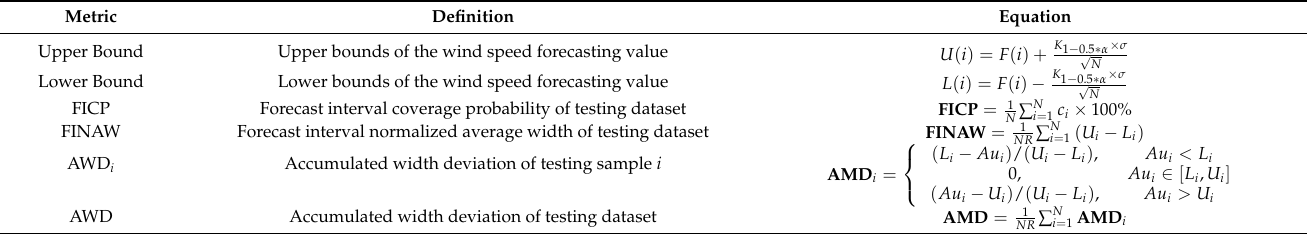
Figure 6. The optimal distribution of forecasting error in CM5. Table 10. Evaluation Index Regulations for Uncertainty Forecasting Performance Table 9. R 2 Values of Each Distribution Fitting.